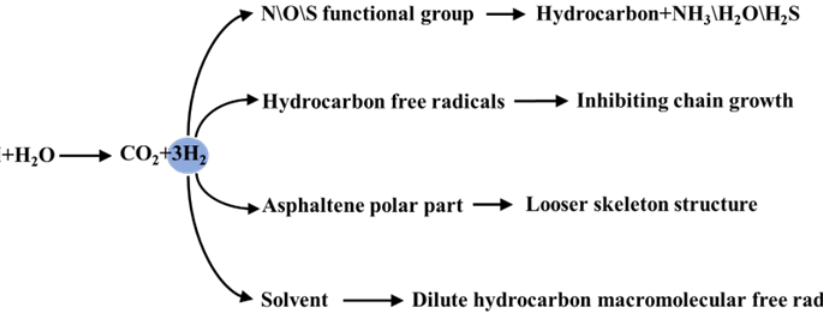
Figure 10. Reaction mechanism.